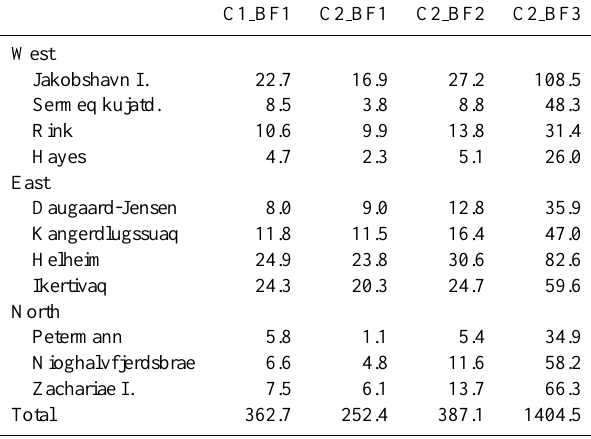
Table 3. Model discharge for individual outlets and the whole ice sheet in Gta − 1 after one century for the various